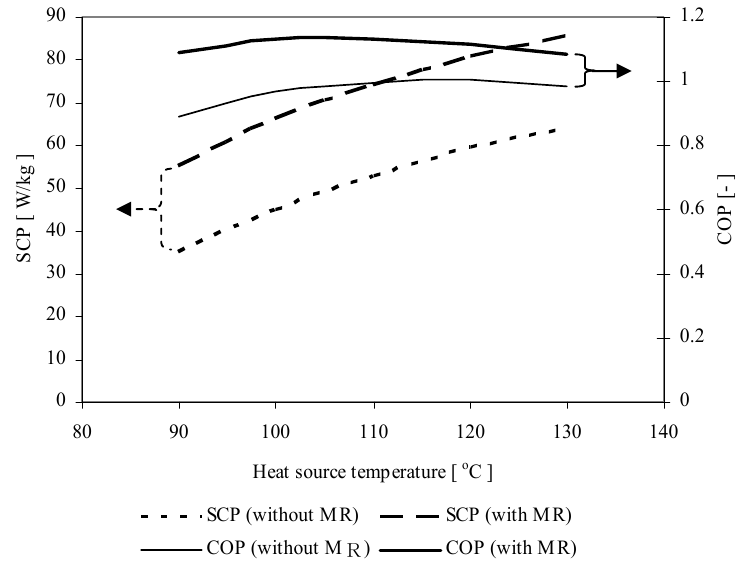
Figure 6. Performance comparison between the cascading cycle with and without mass recovery